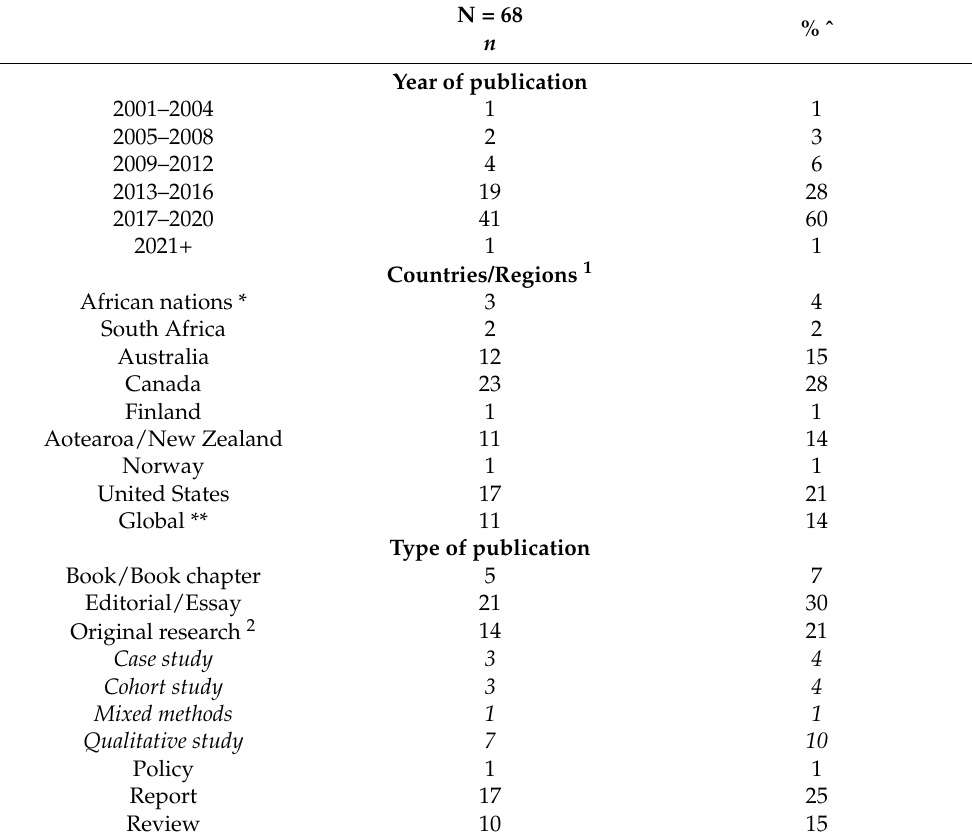
Table 1. Indigenous Data Governance in health research publication